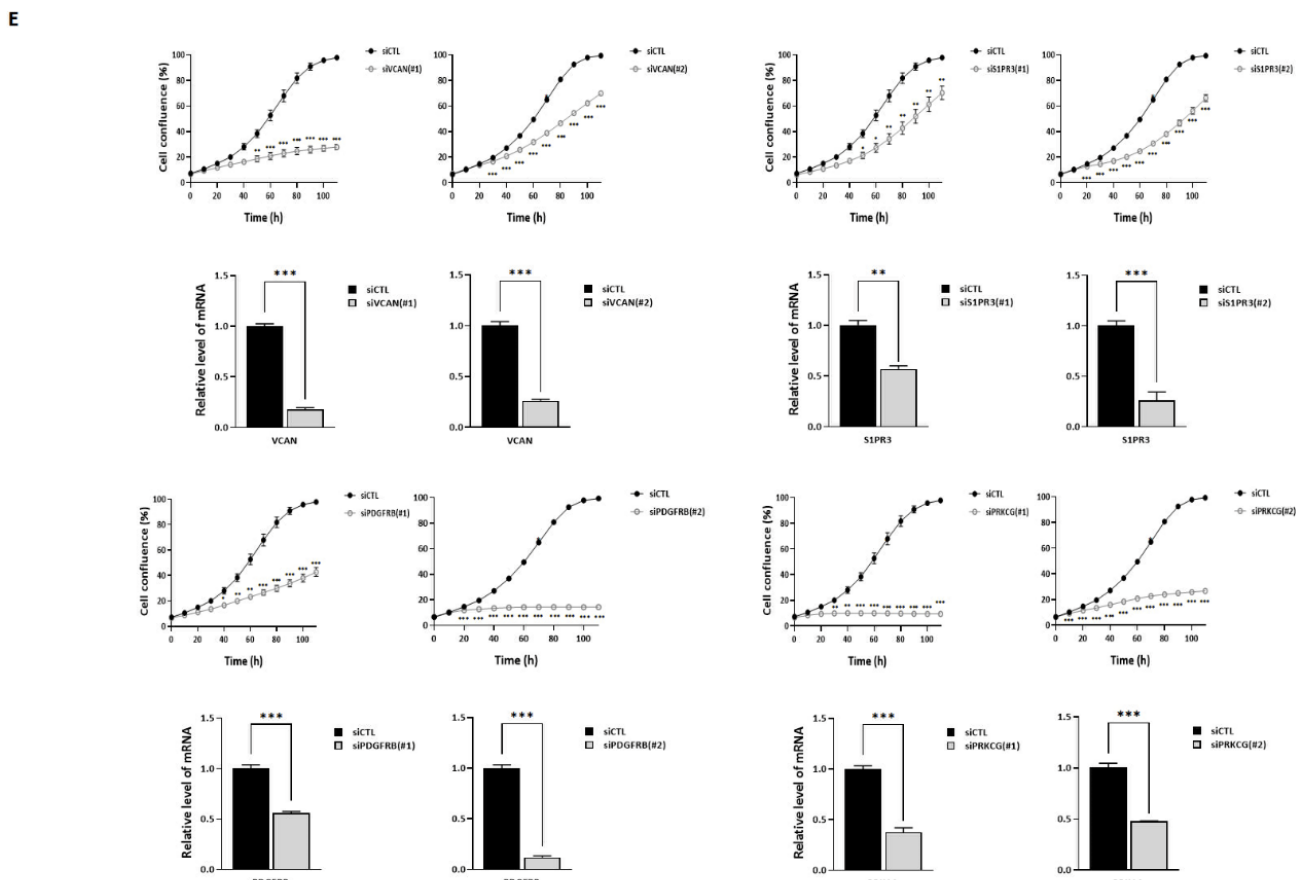
Figure 5. Preliminary investigation of the mechanisms of chemoresistance in UCB cells using comparative gene expression analysis. ( A ) Volcano plot of significantly differentially expressed (SDE) genes in UMUC ‐ 3 ‐ GEMr and T24 ‐ PTXr cells compared to their parental cells. Yellow and blue dots indicate significantly up ‐ and downregulated genes in chemoresistant cells, respectively. In UMUC ‐ 3 ‐ GEMr cells, 568 genes were upregulated, and 675 genes were downregulated; in T24 ‐ PTXr cells, 478 genes were upregulated, and 711 genes were downregulated. FC: fold change. ( B ) Common upregulated gene sets shared by two sets of UMUC ‐ 3 ‐ GEMr and T24 ‐ PTXr cells. Kyoto Encyclopedia of Genes and Genomes (KEGG) pathway enrichment analysis was run based on consistent SDE genes from the upregulated genes in UMUC ‐ 3 ‐ GEMr or T24 ‐ PTXr cells. ( C ) RT ‐ qPCR detected VCAN, S1PR3, PDGFRB, and PRKCG expression in UMUC ‐ 3 and UMUC ‐ 3 ‐ GEMr cells. Error bars indicate the mean ± SEM for three independent regions each. *** p < 0.001. ( D ) Detection of O ‐ GlcNAc modifications of endogenous PDGFRB and PRKCG in UMUC ‐ 3 ‐ GEMr cells. Cells were treated with 2 μ M Thiamet G for 6 h before lysis. Lysates were immunoprecipitated with either anti ‐ PDG ‐ FRB antibody or anti ‐ PRKCG antibody, then immunoblotted against PDGFRB or PRKCG, and O ‐ GlcNAc. ( E ) UMUC ‐ 3 ‐ GEMr cells were reverse transfected with either siCTL or two independent sets of siVCAN, S1PR3, PDGFRB, and PRKCG and incubated in the IncuCyte TM analyzer to monitor cell proliferation. Cell confluence levels were measured using the IncuCyteTM analyzer in real time and are presented as a percentage. The data represent at least three independent experiments and error bars indicate the mean ± SEM. * p < 0.05; ** p < 0.01; *** p < 0.001.